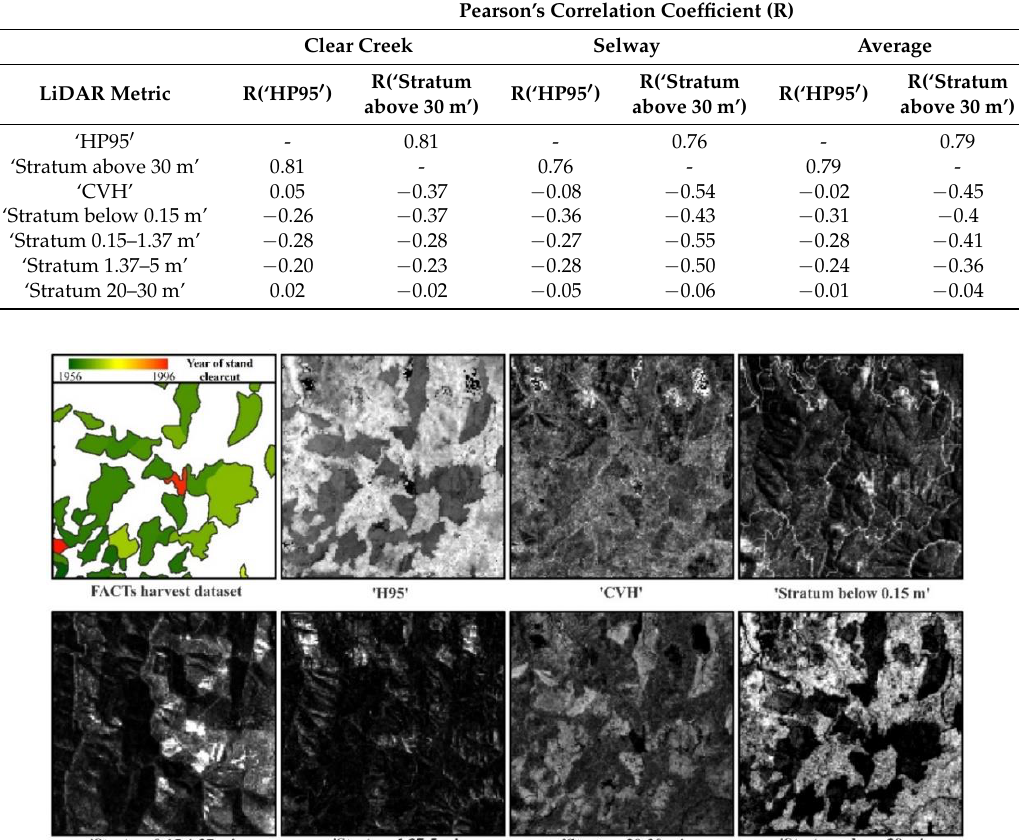
Figure 3. The seven LiDAR metrics considered in the analysis (Table 2), displayed with a linear black to white grayscale color table (1% linear stretch), on a 4 × 4 km subset of the Clear Creek watershed (location on Figure 1). The FACTs harvest reference dataset is presented for comparison in the upper left, to highlight the different response of each metric to even-aged forest stands.